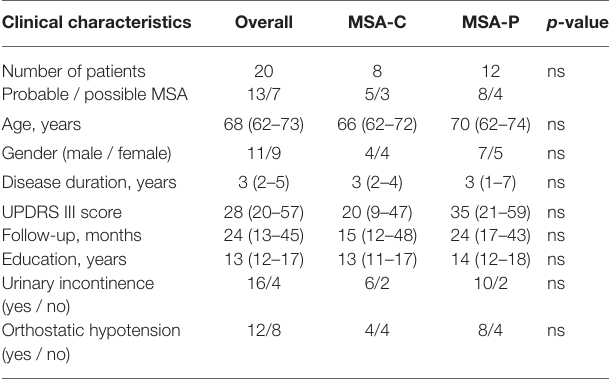
TABLE 1 | Characteristics of the study population at